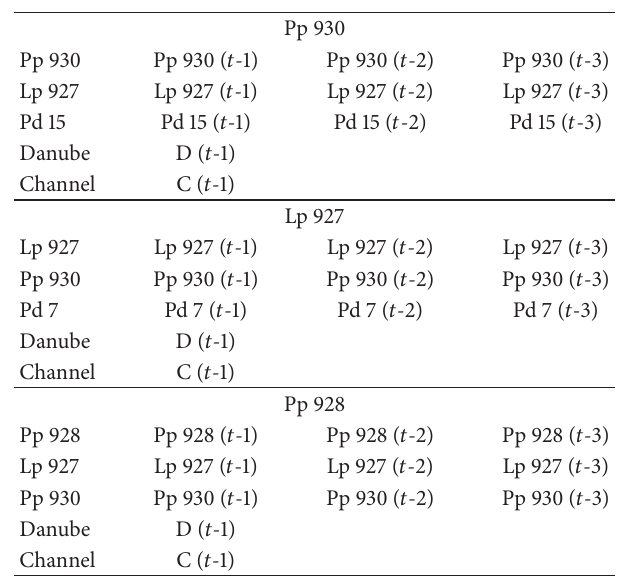
Table 2: Variables in the input vector to ANN and ANFIS models.